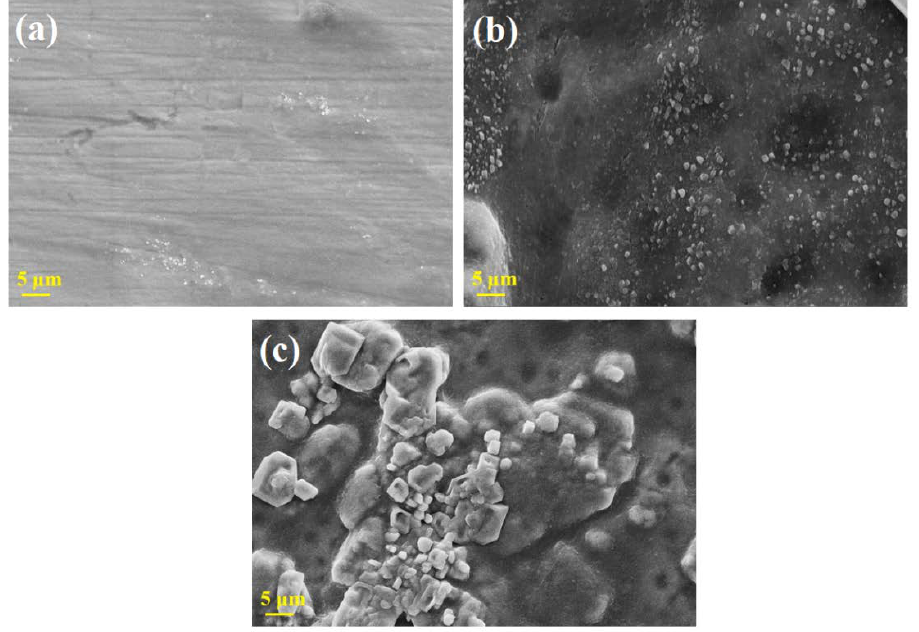
Figure 9. SEM micrographs of attached cells on ( a ) bare specimen ( b ) PEO-coated specimen, and ( c ) SBF-immersed sample. ( c ) SBF-immersed